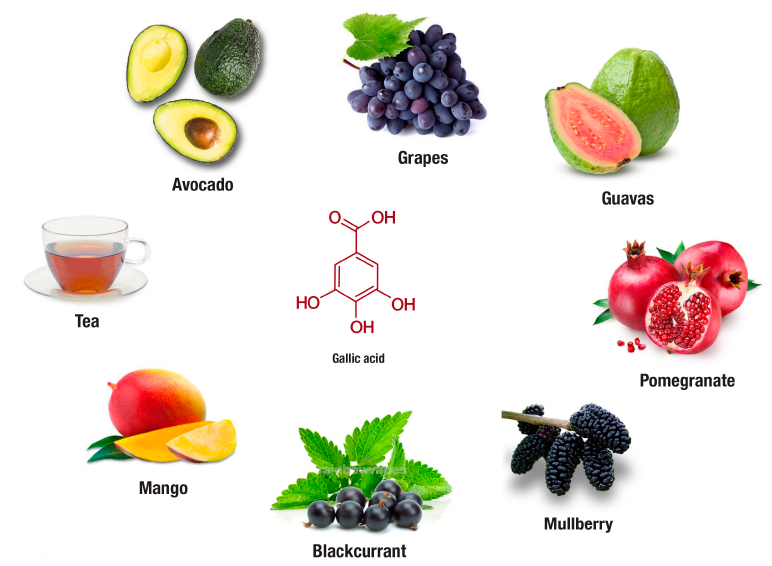
Figure 4. In addition to tea, avocado, blackcurrant, grapes, guava, mango, mulberry and pomegranate are some plants rich in gallic acid or its derivative compounds that are increasingly investigated for their anti-obesity properties. The following websites were used for the extraction of